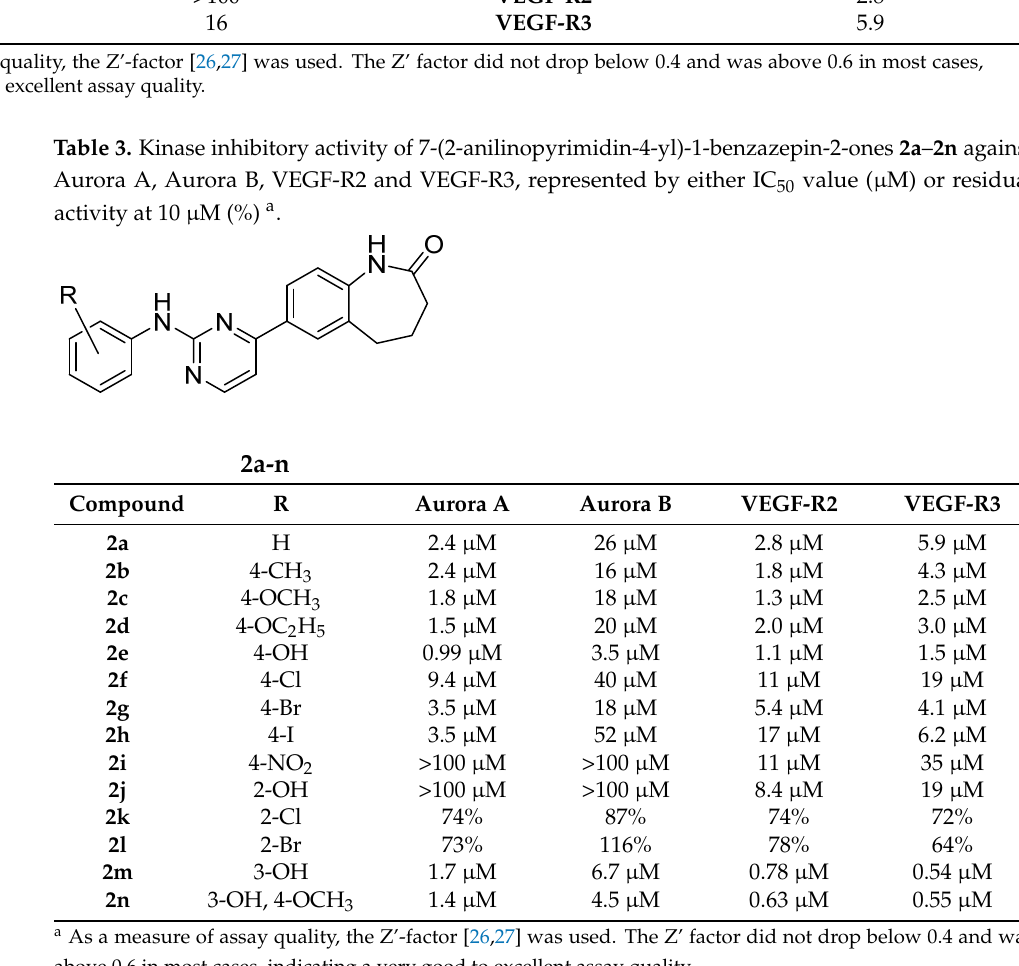
Table 4. Aurora A kinase inhibition a and kinetic solubility b of 7-(2-anilinopyrimidin-4-yl)-1-ben- zazepin-2-ones 2a , m , n and 14a - g .